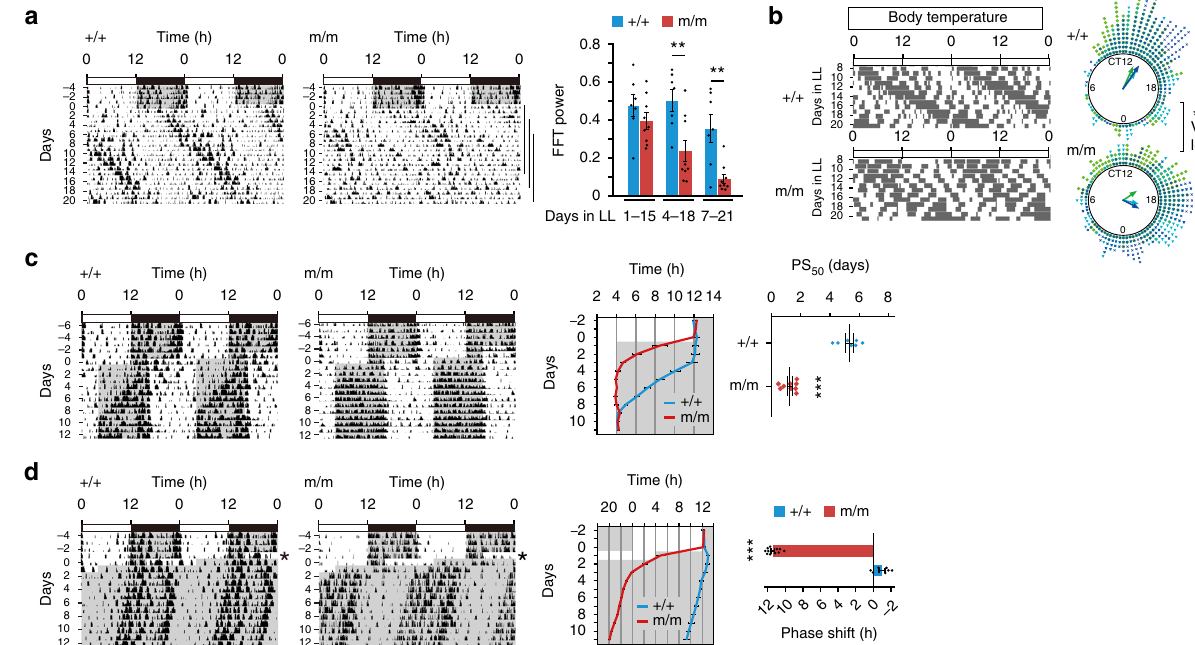
Fig. 4 a Destabilized circadian locomotor activity and body temperature rhythms of Per2 E ′ -box mutant mice. Representative locomotor activity records of Per2 E ′ + / + and Per2 E ′ m/m mice under light/dark (LD) followed by constant light (LL). The graph shows changes in FFT power in LL. ** P < 0.01, two-way repeated-measures ANOVA, Bonferroni post hoc test ( Per2 E ′ + / + , n = 7; Per2 E ′ m/m , n = 9). b Representative body temperature records of Per2 E ′ + / + and Per2 E ′ m/m mice in LL. The mean temperature of the entire data series was calculated, and the data points above the mean are plotted. Rayleigh plots show phase distribution of elevated body temperature on days 7 – 21 ( n = 3, each genotype). Data from independent animals are color-coded. Arrow length re fl ects the r -value of each distribution. * P < 0.05, two-tailed unpaired t -test. c Representative records of locomotor activity (left) and plots of activity onset (middle) of Per2 E ′ + / + and Per2 E ′ m/m mice before and after an 8-h phase advance in LD cycles. The PS 50 values represent the time required for 50% phase-shift (right). *** P < 0.0001, two-tailed unpaired t-test ( Per2 E ′ + / + , n = 7; Per2 E ′ m/m , n = 9). d Representative locomotor activity records (left), activity onset (middle), and magnitude of phase-shift (right) of Per2 E ′ + / + and Per2 E ′ m/m mice subjected to an 8-h phase advance on day 1 and released